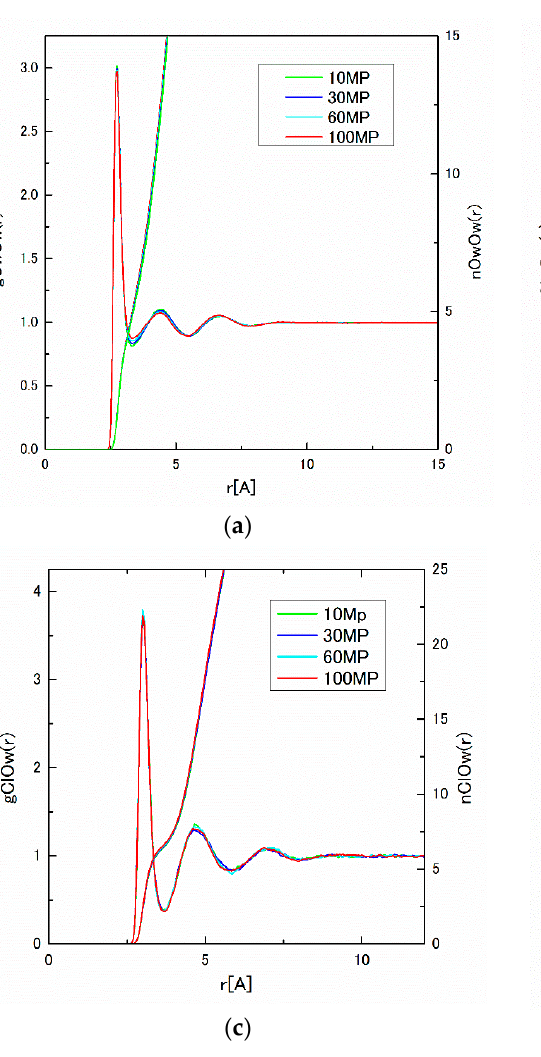
Figure 11. ( a ) g OwOw ( r ) and n OwOw ( r ); ( b ) g NaOw ( r ) and n NaOw ( r ); ( c ) g ClOw ( r ) and n ClOw ( r ) ; and ( d ) g CH4Ow ( r ) and n CH4Ow ( r ) under pressures of 10–100 MP.